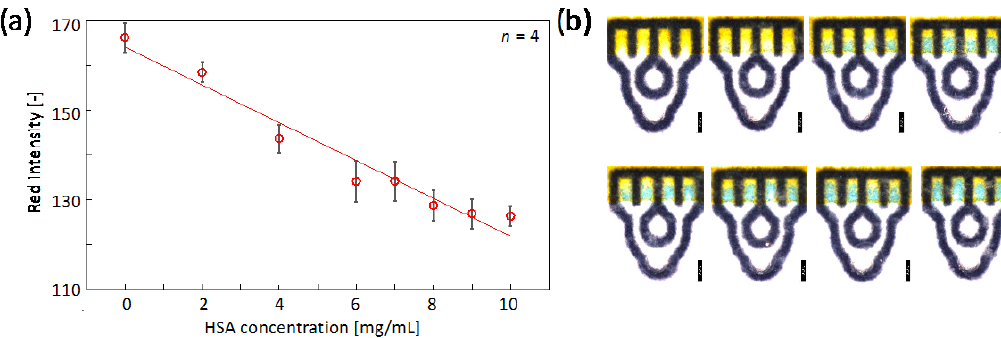
Figure 6. Colorimetric human serum albumin (HSA) analysis through the application of 0.8 µL of sample liquid to an optimized µPAD. ( a ) Calibration curve with data plots and error bars representing mean red intensities and corresponding standard deviations extracted from the four detection zones (parameters of regression line shown in Table 4). ( b ) Micrographs of µPADs after application of 0, 2, 4, 6, 7, 8, 9, and 10 mg/mL HSA (from upper left to lower right). The scale bars correspond to a length of 1 mm (brightness and contrast adjusted for improved visibility). Table 4. Slope and y-intercept values of linear HSA response curves (0–10 mg/mL) recorded by application of variable sample volumes.